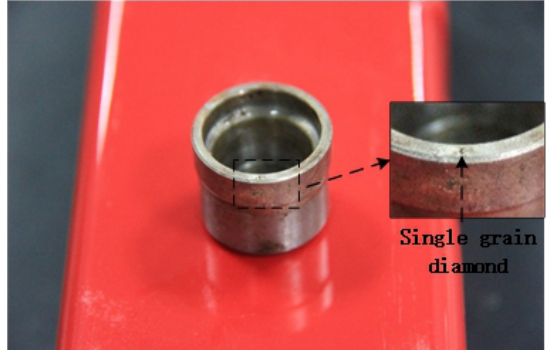
Figure 3. Ultrasound-assisted cutting tool with a single abrasive